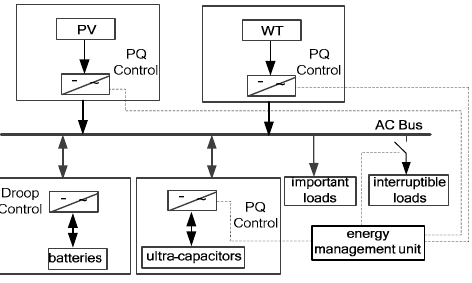
Figure 10. Simulation model of microgrid.